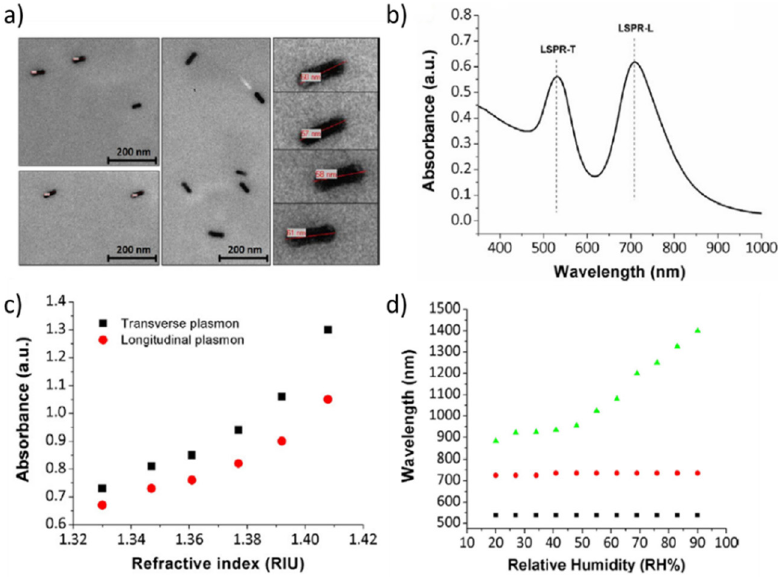
Figure 12. ( a ) Morphology and aspect-ratio of the gold nanorods; ( b ) Location of the transversal plasmon resonance (LSPR-T) and longitudinal plasmon resonance (LSPR-L); ( c ) Changes in intensity of the LSPR bands for variable refractive index values; ( d ) Wavelength shift of the LSPR and LMR bands for RH% changes. Reprinted with permission of [58].